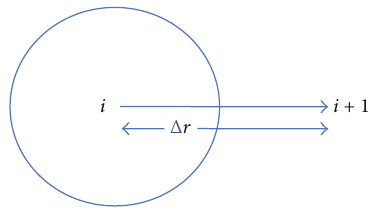
Figure 3: Discretisation for centre line